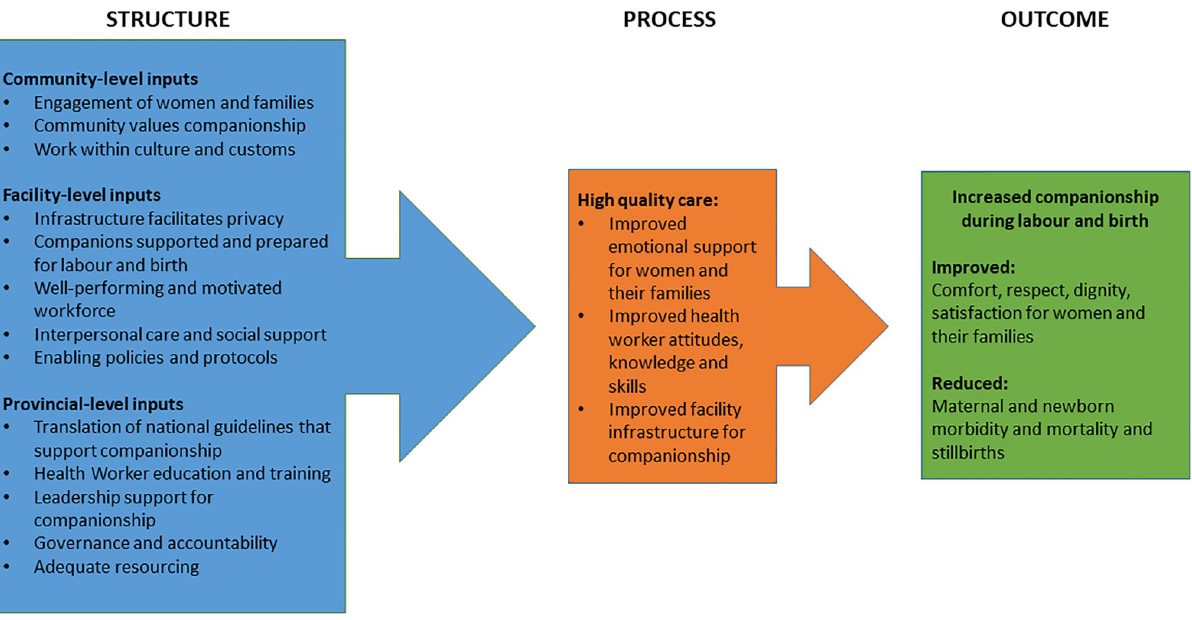
Fig 2. Conceptual framework for enabling companionship.